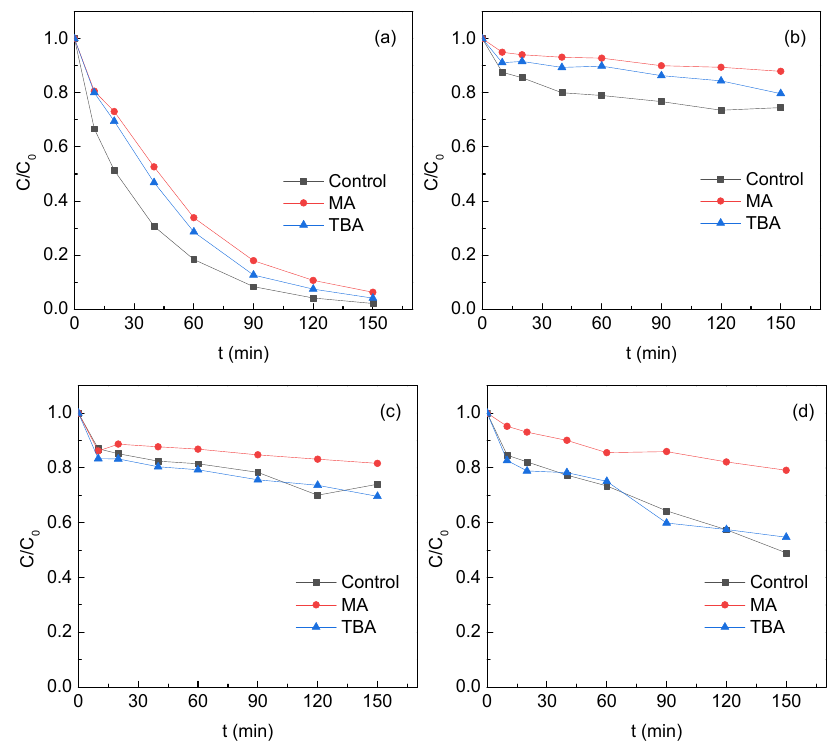
Figure 7. MA and TBA influence on SMT removal in PS activation by ( a ) S1, ( b ) S2, ( c ) S3 and ( d ) S4. Reaction conditions: [SMT] 0 = 5 mg/L, [PS] 0 = 4 mM, [TM] 0 = 5 g/L, [MA] 0 = [TBA] 0 = 50 mM, pH 0 = 5 and T = 25 ◦ C. ( a ) was drawn with modification after Zhang et al.